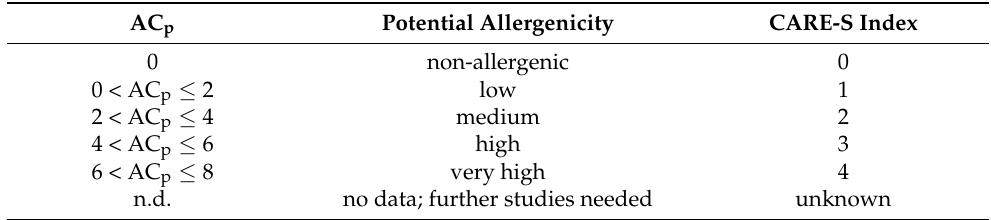
Table 1. Values of the CARE-S index and the corresponding levels of potential allergenicity. AC p = raw calculated value of allergenicity categories